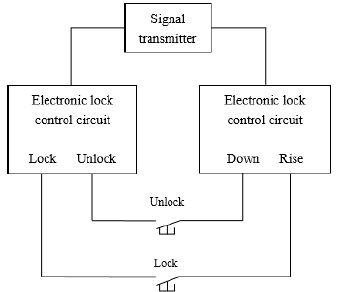
Fig. 3. Control circuit ladder Fig. 4. The schematic diagram of remote control